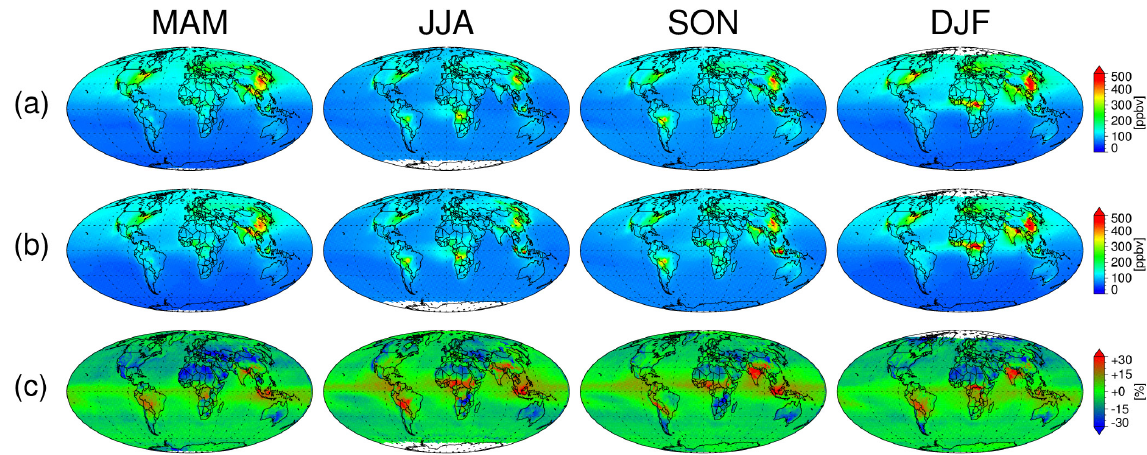
Figure 5. Global distributions of seasonal (a) MOPITT-retrieved surface CO, (b) pseudo-retrievals of EMAC-simulated surface CO based on RG scenarios, and (c) their relative difference between 2001 to